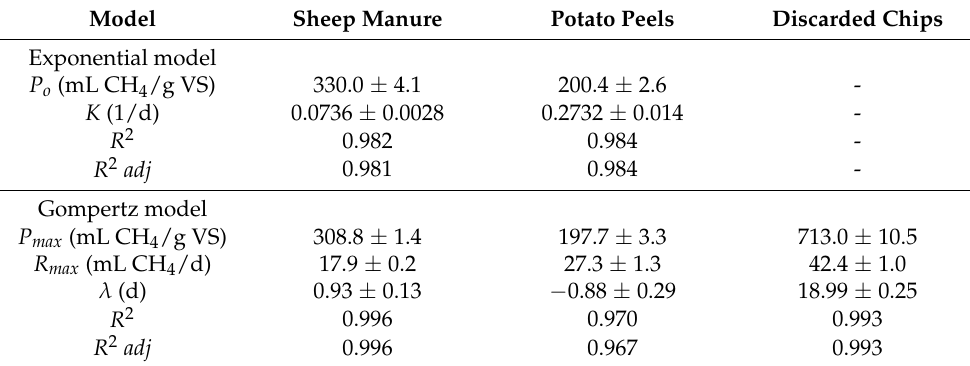
Table 2. Parameters obtained from the exponential modified Gompertz